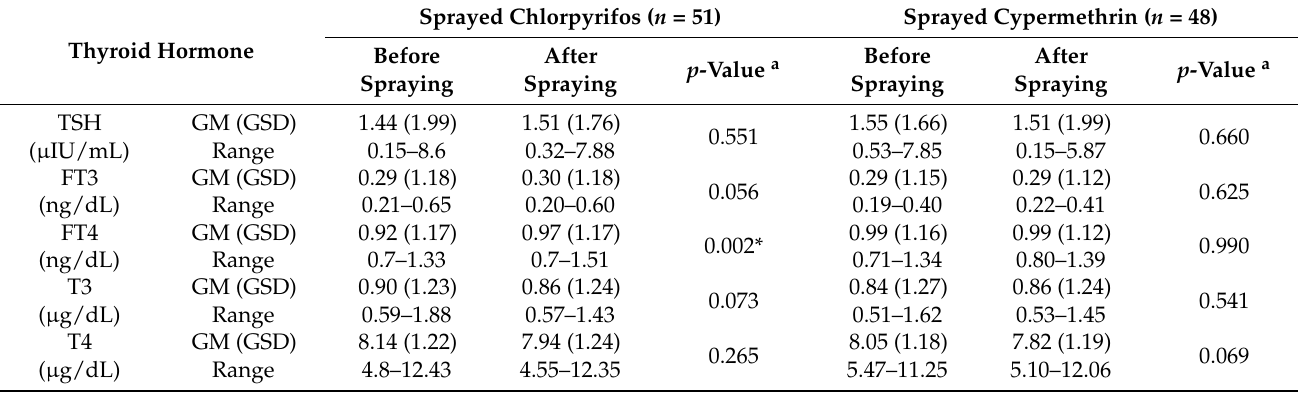
Table 5. Comparison between thyroid hormones on the day before and the day after spraying insecticides chlorpyrifos and cypermethrin.